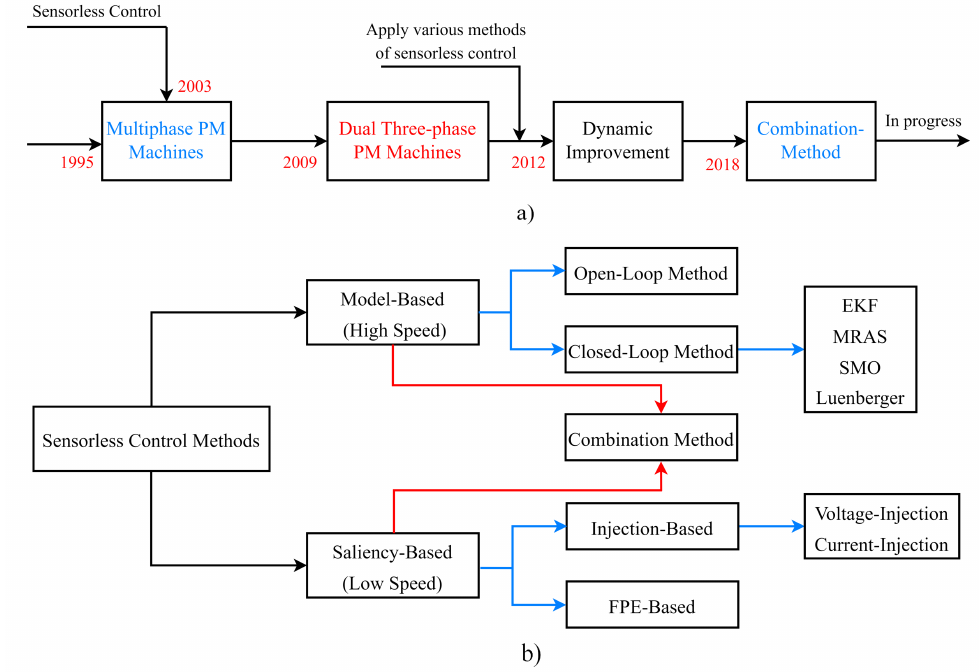
Figure 3. ( a ) Historical development of sensorless control for multiphase and DTP-PMSM drives; ( b ) classification of sensorless